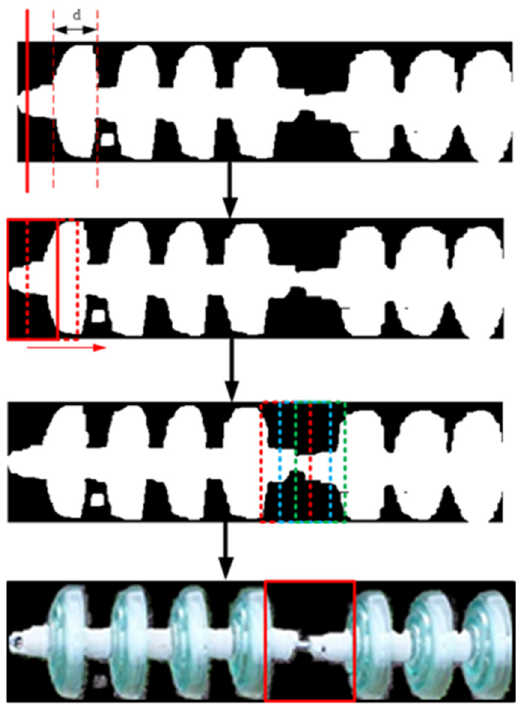
Figure 9. Detection of missing insulator caps.